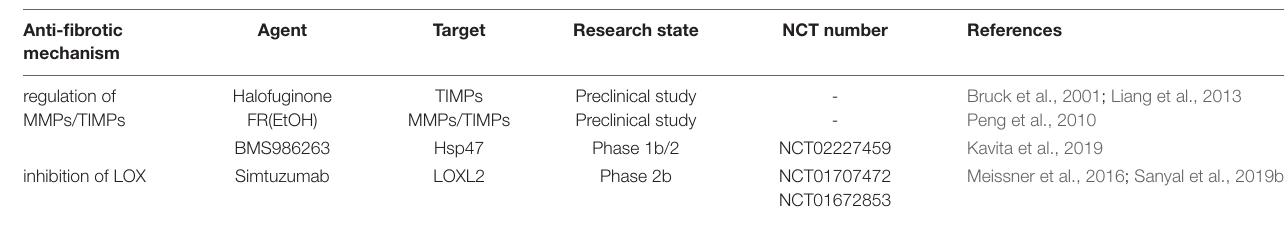
TABLE 3 | Anti-hepatic fibrosis drugs related to inhibiting ECM. Anti-fibrotic